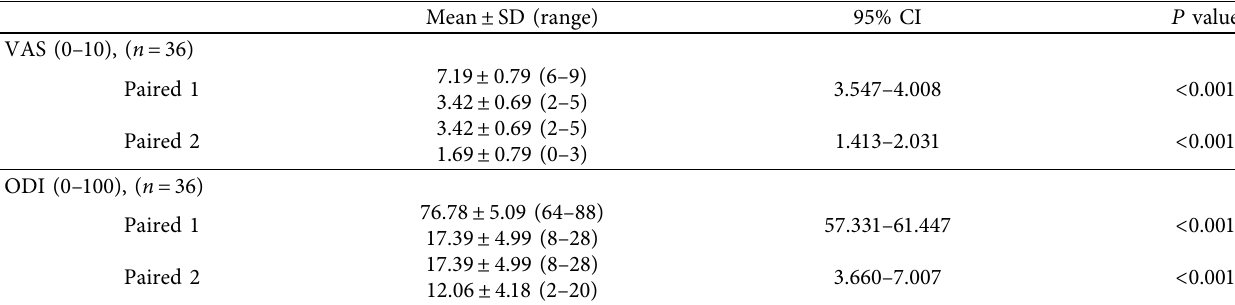
Table 3: Comparison of VAS and ODI before and after VA.